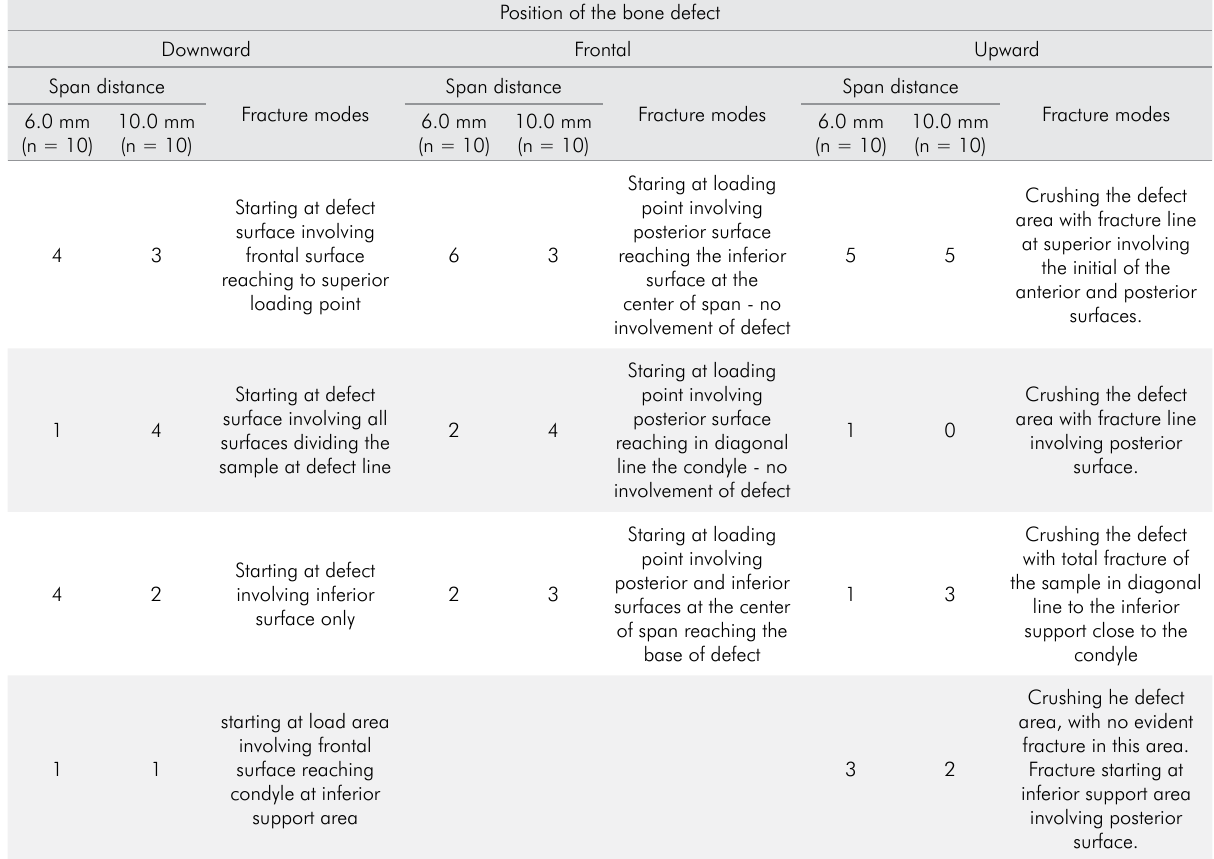
Table 2. Classification of the fracture mode for tibiae after three-point bending tests. Position of the bone defect